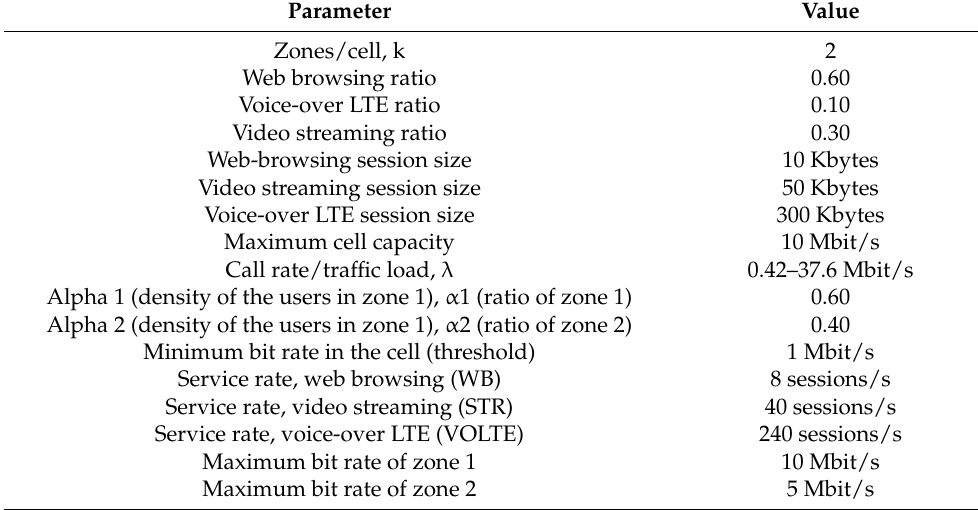
Table 4. Simulation parameters.